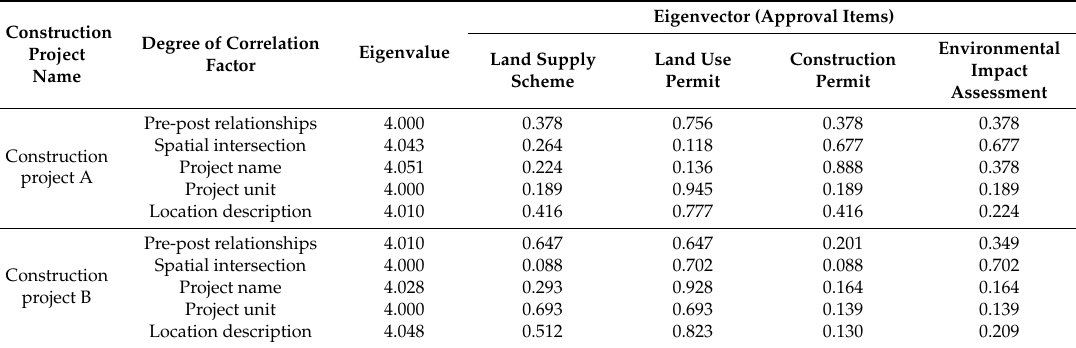
Table 5. The results for the two construction projects, including the maximum eigenvalues and the corresponding